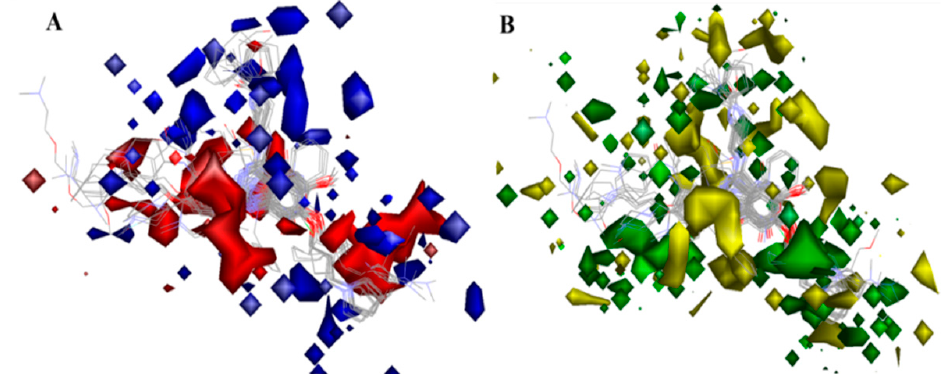
Figure 10. ( A ) 3D ‐ QSAR model coefficients on electrostatic potential grids. Blue represents positive coefficients; red represents negative coefficients. ( B ) 3D ‐ QSAR model coefficients on Van der Waals grids. Green represents positive coefficients; yellow represents negative coefficients.